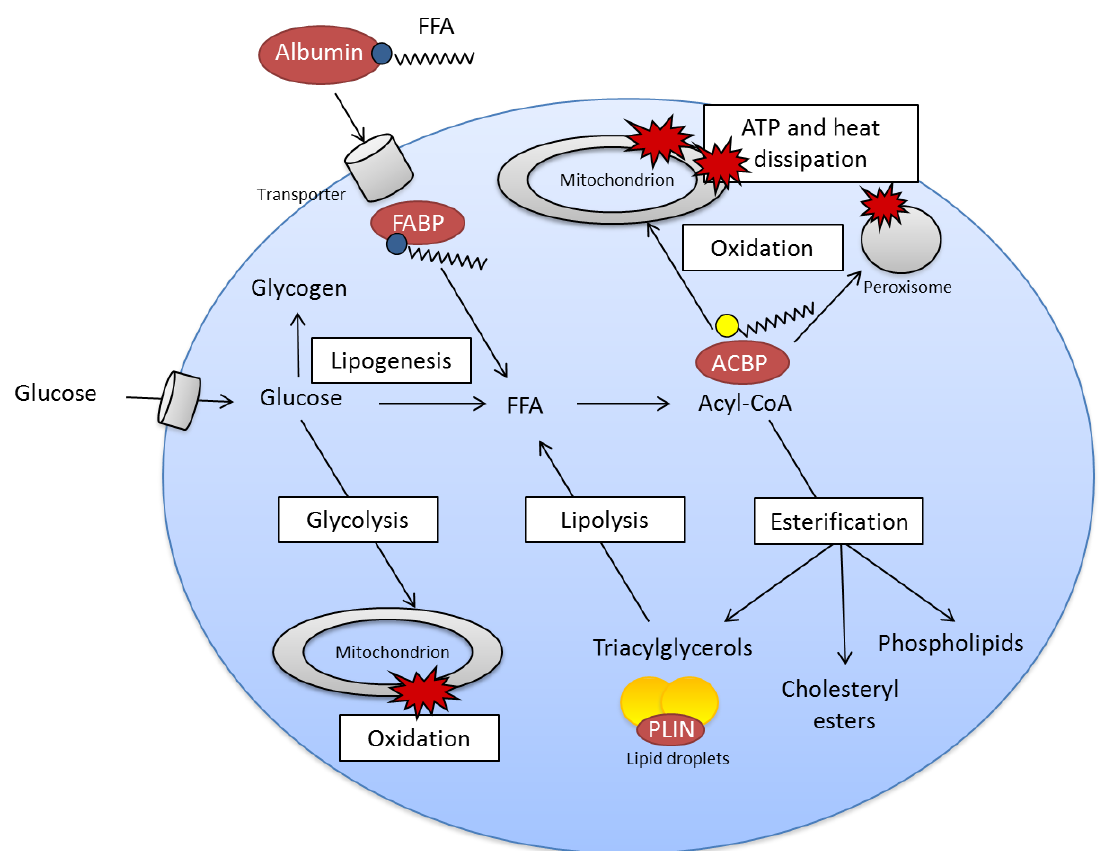
Figure 2. Simplified view of fatty acid